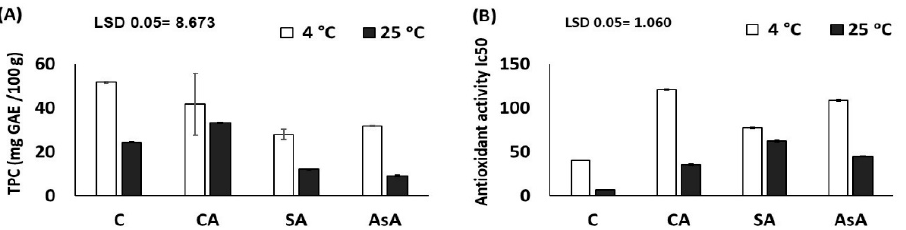
Figure 11. Effects of bio-stimulants B, control (C), citric acid (CA), salicylic acid (SA) and ascorbic acid (AsA) and storage temperature T (4 °C and 25 °C) on total phenol compounds TPC ( A ) and antioxidant activity ( B ) of okra pods stored for 12 days. Error bars are the ± SD of the means of three biological replicates. LSD values ( p ≤ 0.005) for TPC ( A ): B = 6.1 and T = 4.3. LSD values ( p ≤ 0.05) for antioxidant activities ( B ): B = 0.75 and T = 0.53. LSD for B × T is displayed on the